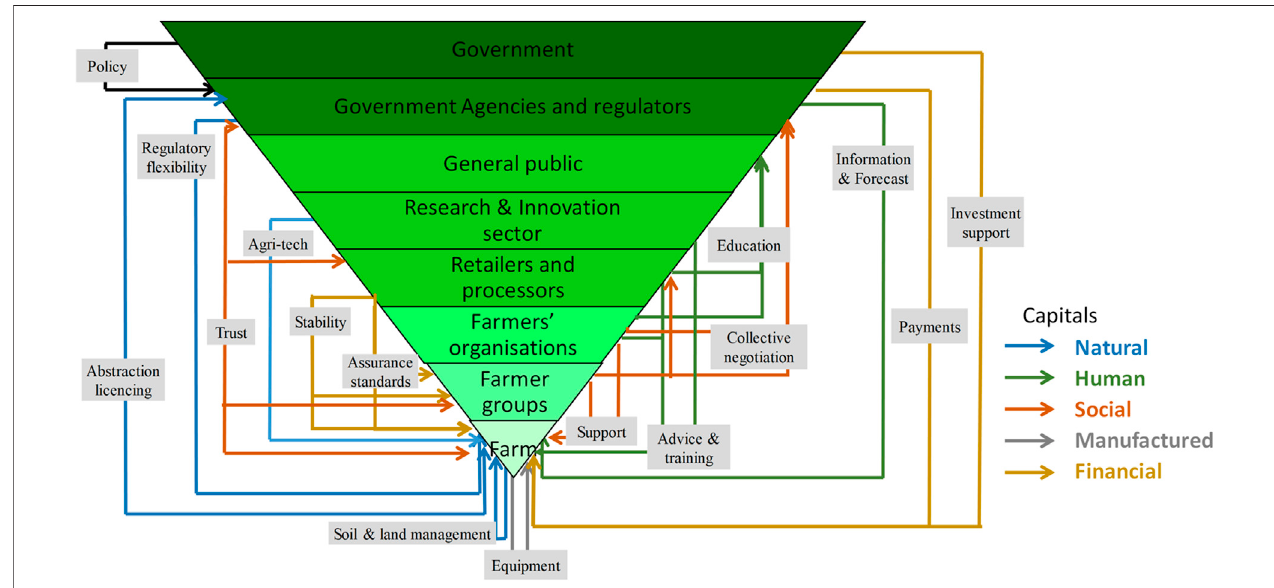
FIGURE 6 | Drought management framework for agriculture, showing the multiple levels of institutions and the relationships between broad actions and capitals.